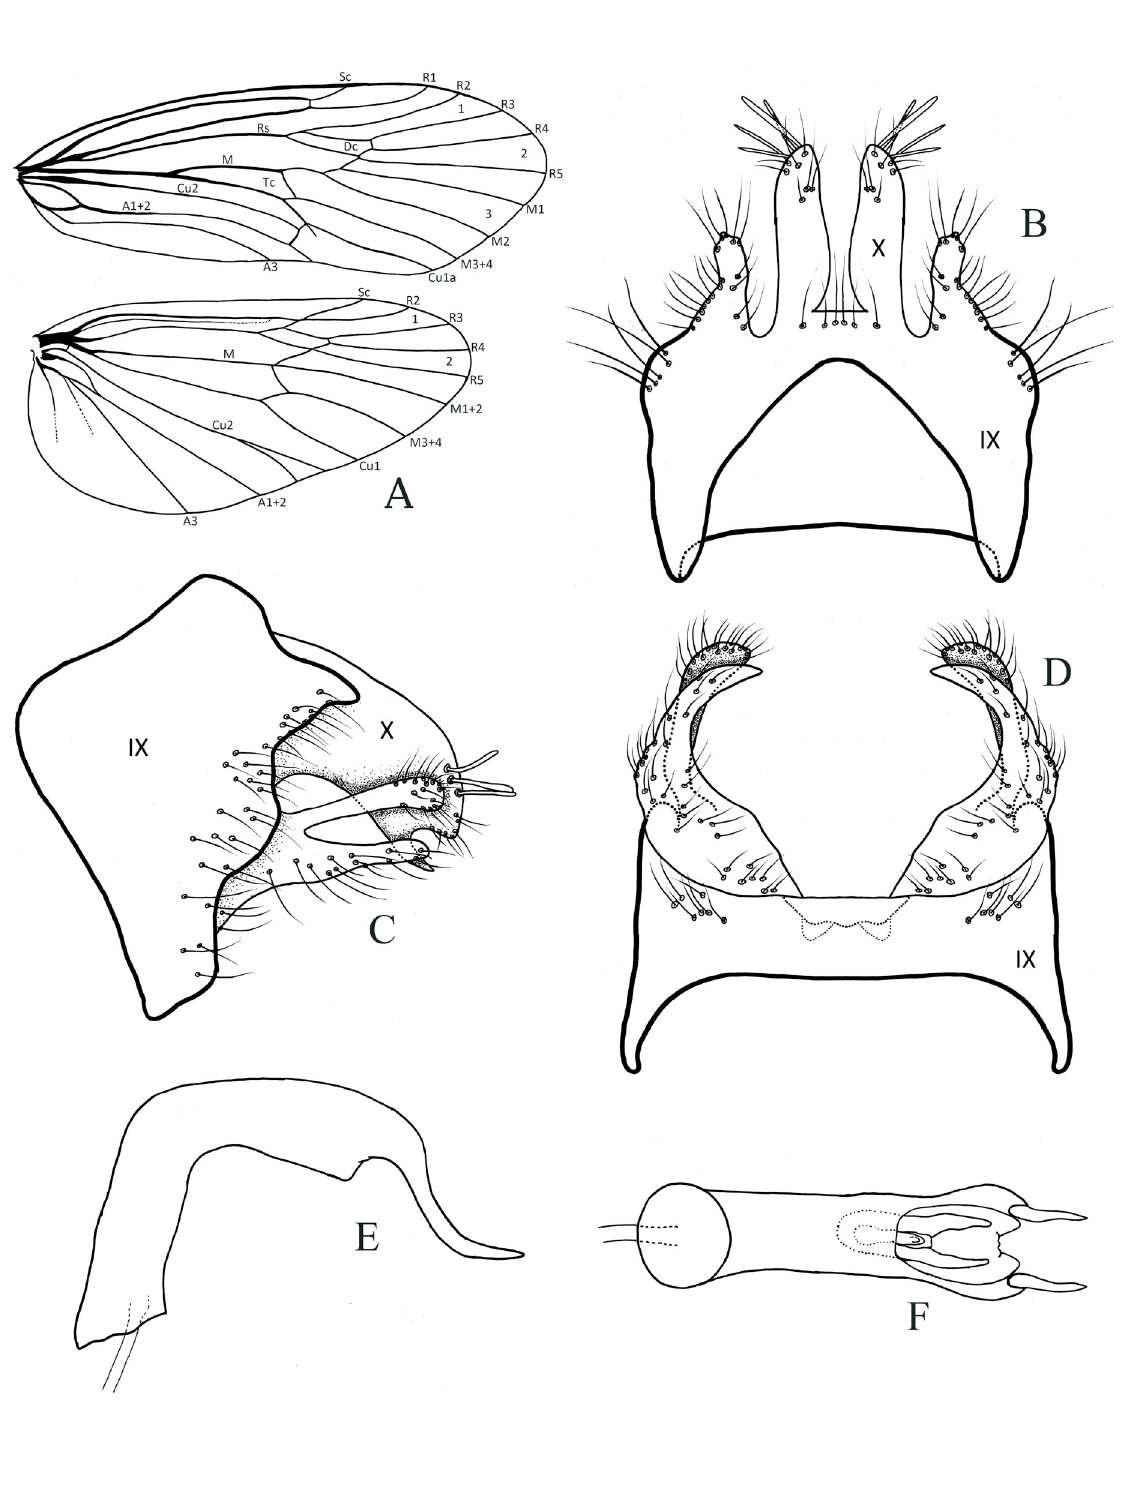
Fig. 5. Silvatares laetae Ngirinshuti & Johanson sp. nov., ♂, holotype. A . Right wings. B–D . Genitalia. B . Dorsal view. C . Lateral view. D . Ventral view. E–F . Phallus. E . Lateral view. F . Ventral